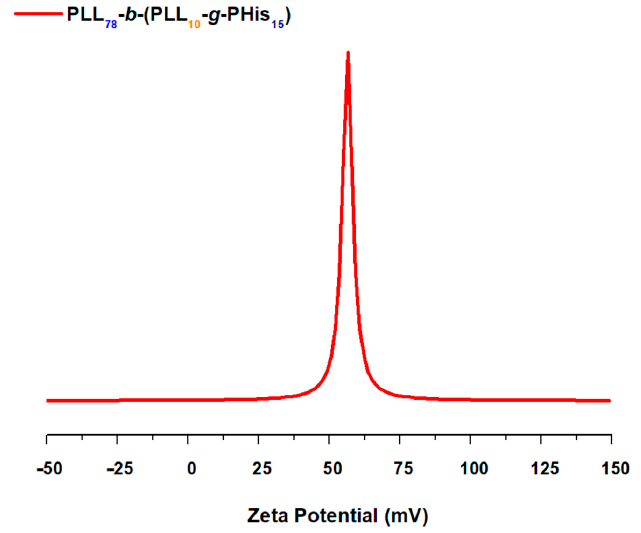
Figure 17. ζ -potential measurement of PLL 78 – b –(PLL 10 – g –PHIS 15 ) at neutral pH value.